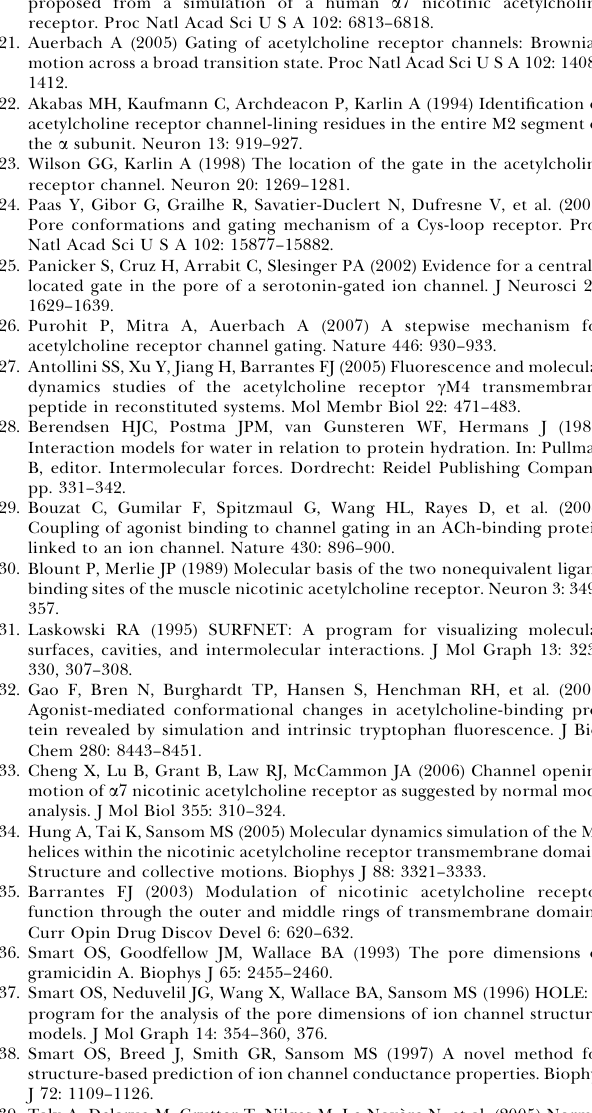
Figure S1. The Time-Dependent RMSDs for the C a Atoms of Each Subunit and Helix of the EC Domain (A) and Five M2 Helices (B) with Respect to Their Starting Structures Found at doi:10.1371/journal.pcbi.0040019.sg001 (1.2 MB TIF). Figure S2. Motions of nAChR Revealed by the First Mode of the Normal Mode Analysis (NMA) on the Snapshot Extracted from the 20th ns of the CMD Simulation Top (A) and side (B) views of periodic snapshots of the EC domain, as well as the corresponding top (C) and side (D) views of periodic structures of the M2 helices, are shown by superposing the starting conformation (green), and conformations at the one-fourth (red) and the three-fourth (blue) harmonic period. Found at doi:10.1371/journal.pcbi.0040019.sg002 (8.8 MB TIF). Figure S3. Angular Displacements of the EC Domain, M1–M4 Helices, and MA Helices with Respect to the Starting Structure Found at doi:10.1371/journal.pcbi.0040019.sg003 (280 KB TIF).